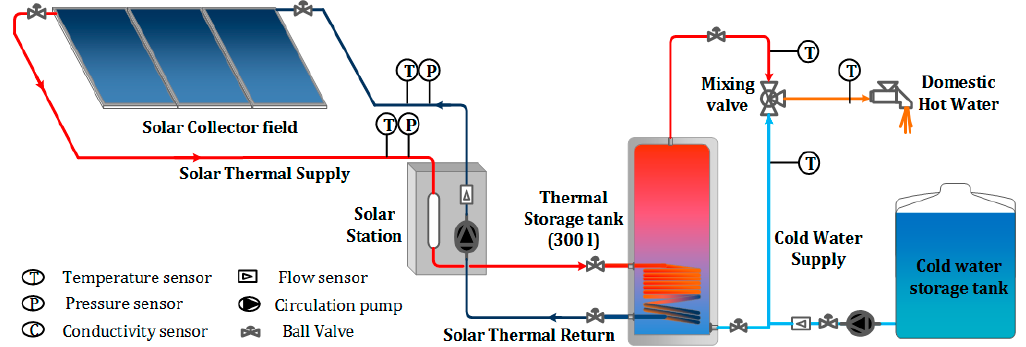
Figure 2. Schematic showing individual operation of solar domestic hot water (SDHW).